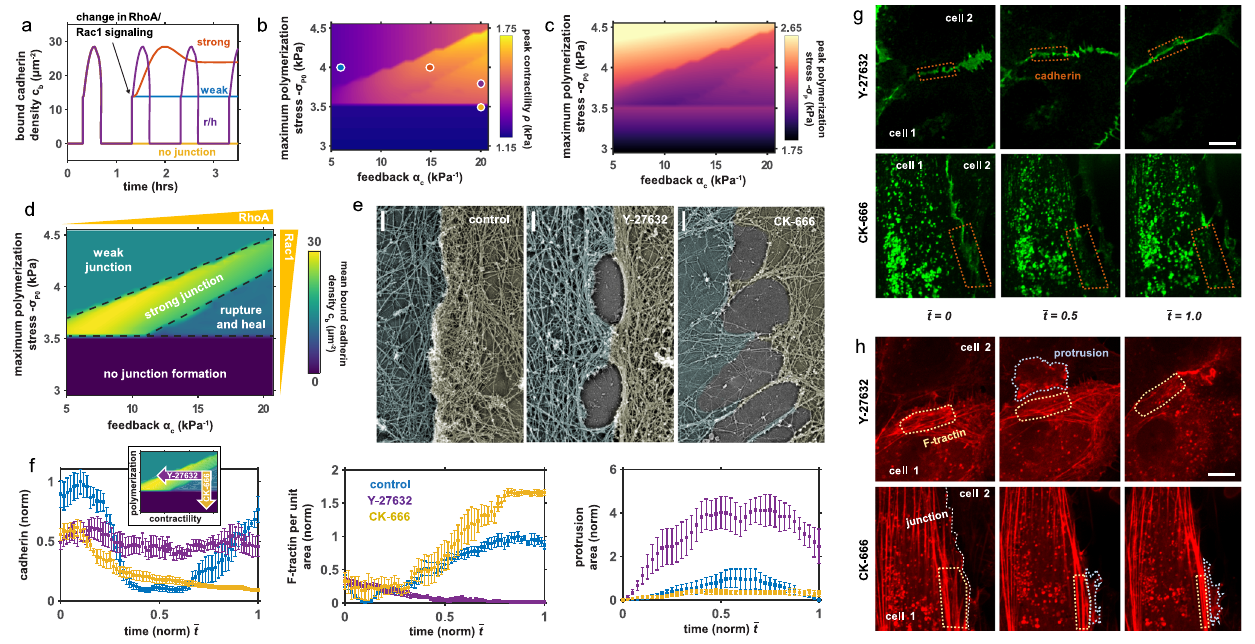
Fig. 5 | In fl uence of pharmacological treatments on junction stability. a Transients in bound cadherin following altered RhoA or Rac1 signaling which underpins strong, weak, rupture/heal junctions or disconnected cells. Corre- sponding parameters shown on ( b ); Predicted ( b ) cell contractility and ( c ) poly- merization induced stress in the phase space spanned by RhoA-associated feedback parameter α c and Rac1-associated maximum polymerization stress σ P 0 ; ( d ) Phase diagram of junction behavior as driven by actin polymerization and adhesion-mediated feedback, showing bound cadherin density; ( e ) PREM images of HUVECs showing cytoskeleton organization and junction state associated with